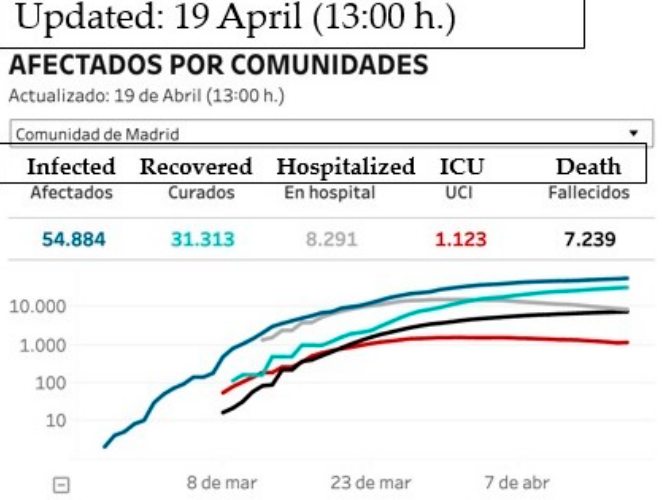
Figure 6. Evolution of the number of people that were infected, recovered, hospitalized, in an ICU (intensive care unit), or dead in the region of Madrid in March and April 2020 [61]. A period is used to indicate the decimal place.